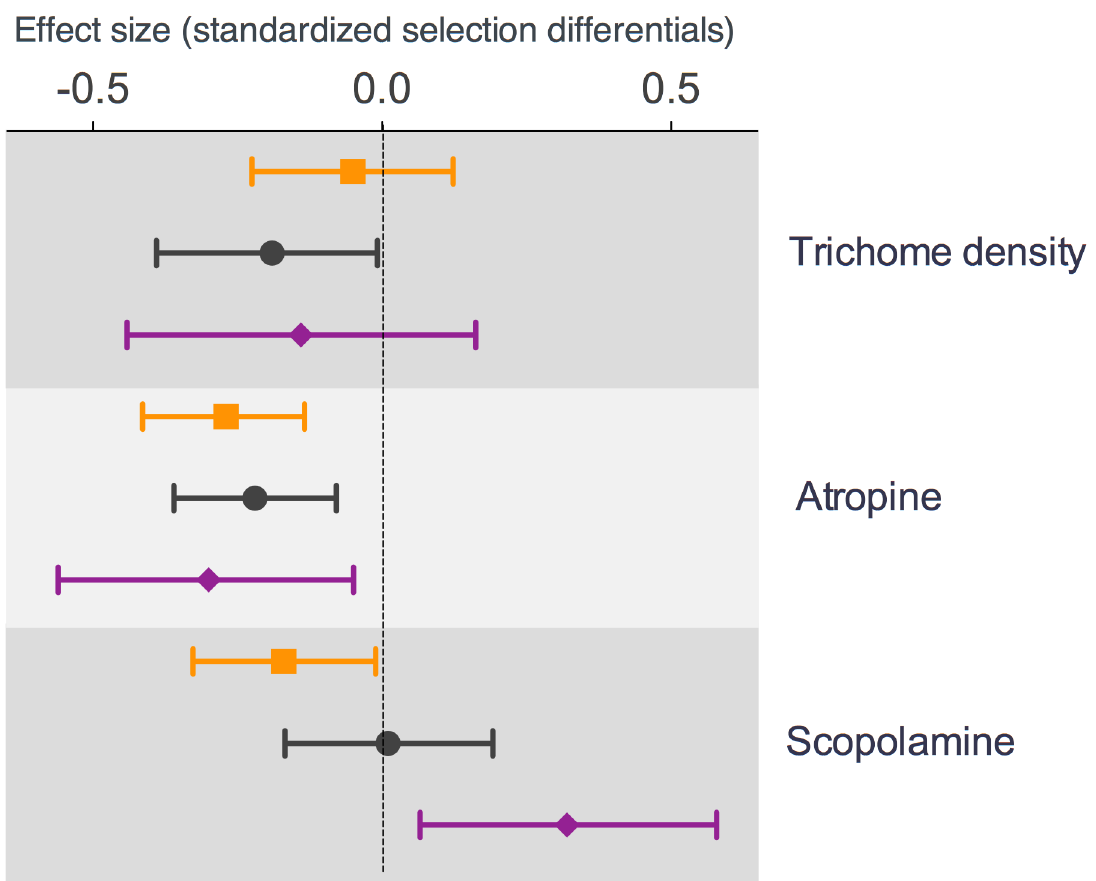
Figure 2. Forest plot showing the mean effect size for standardized selection differentials ( S ) of each defensive trait and corresponding confidence interval at 95%. Different colors and forms denote different species of herbivores: Tangerine squares: Lema daturaphila ; black circles: Epitrix parvula , and purple diamonds: Sphenarium purpurascens . Corresponding values are reported in Table S3. Figure S1 Among-population variation in a) leaf tri- chome density, b) atropine concentration, and c) scopolamine concentration in eight populations of Datura stramonium in central Mexico. Bars represent average value + 1 standard error. Table S1 Datura stramonium populations sampled in August-September 2011. DS = Desert shrub, POF = Pine- Oak forest TDF = Tropical deciduous forest. Table S2 Correlations ( r ) between trichome density, scopolamine, and atropine concentration in eight pop- ulations of Datura stramonium in central Mexico. Significant correlations appear in bold-type fonts. Table S3 Effect sizes for selection differential ( S ) and gradients ( b ) of selection with their corresponding confidence intervals at 95% (in parentheses). An omnibus test ( Q m ) evaluates whether parameters are equal among groups